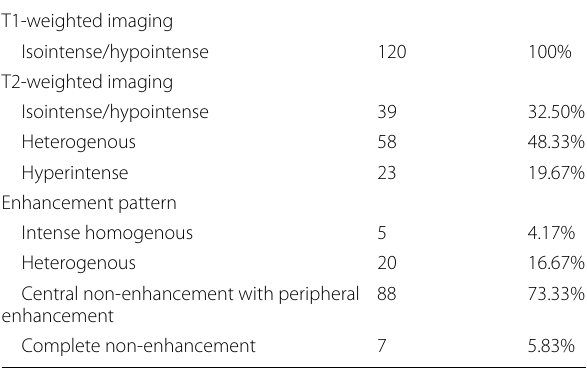
Table 1 MR features of sino-nasal lesions